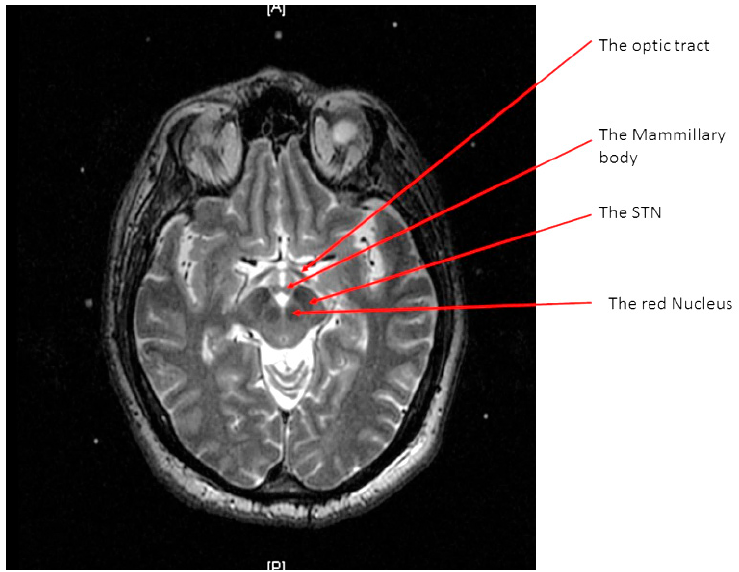
Figure 2. An axial T2 weighted magnetic resonance imaging (MRI) image at the level of the subthalamic nuclei (STN).